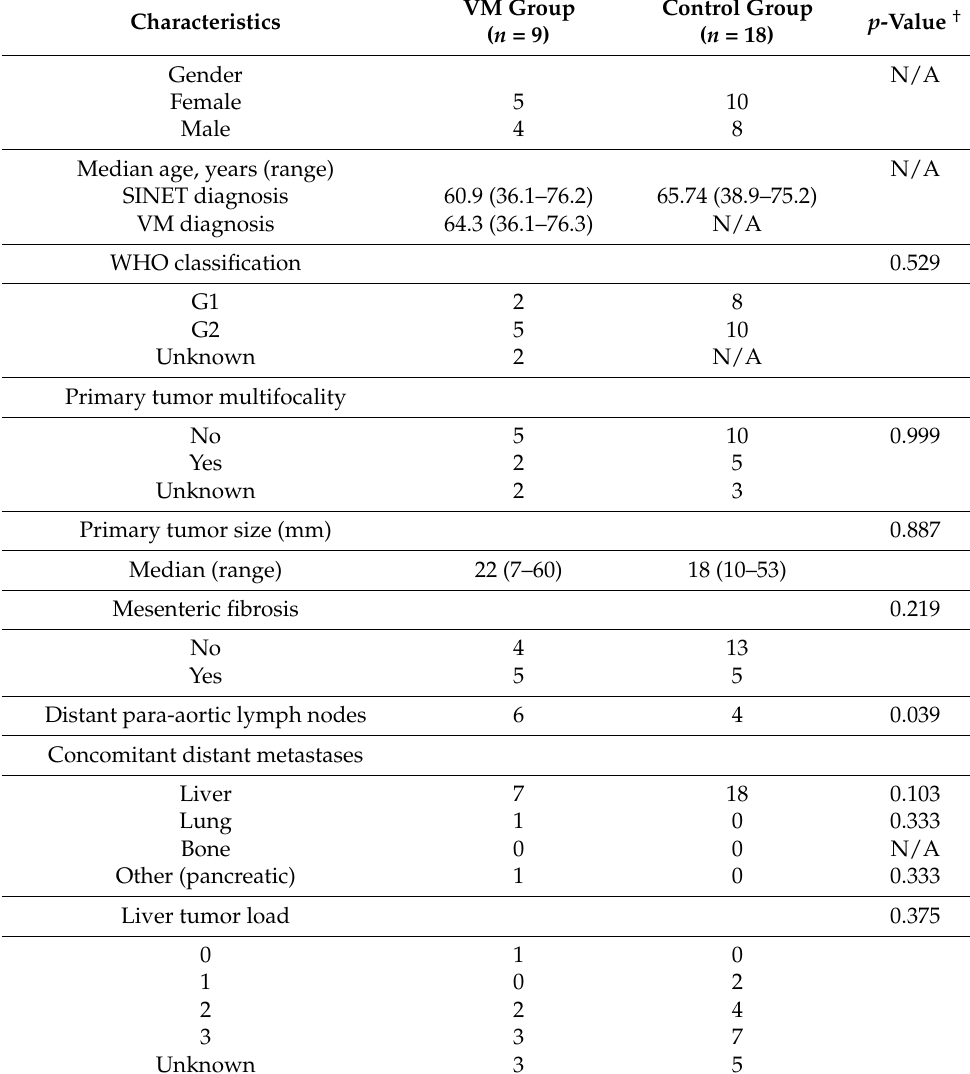
Table 1. Patients’ baseline characteristics at the time of Virchow’s metastasis (VM) diagnosis ( n = 9) and characteristics of the age- and sex-matched control group with stage IV disease ( n = 18).